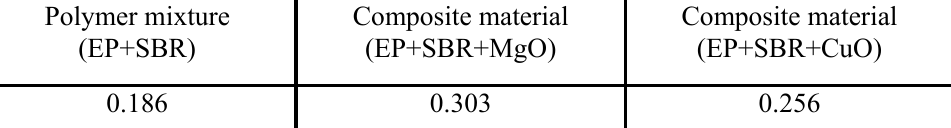
Table 5: Effect of nano filler on the thermal conductivity values.